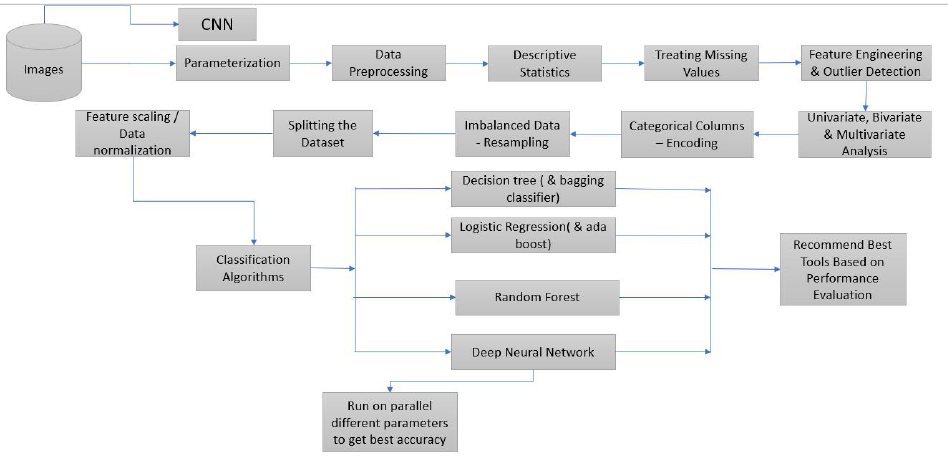
Figure 2. Flow chart of the methodology used to compare between different models.